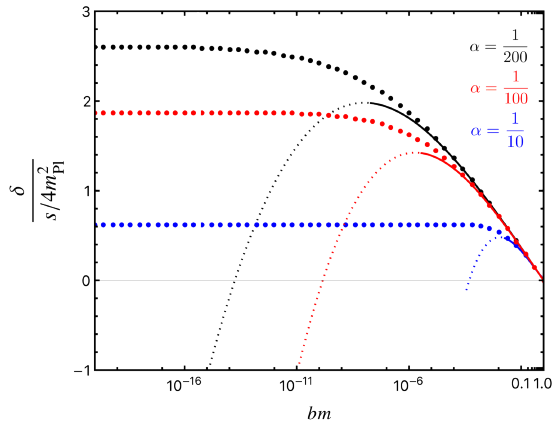
Figure 5 . Quantum corrections to the phase shift in the vector case with IR Sudakov double-logs resummation as a function of bm , choosing for simplicity b IR = 1 /m . The dots reproduce the full numerical solution for α = 1 / 10 (blue), α = 1 / 100 (red), and α = 1 / 200 (black). The solid lines for p Exp( − π/ 2 α ) < bm < 1 are the analytic approximation based on eq. (2.21). If extrapolated to the p region bm < Exp( − π/ 2 α ) , the phase shift would turn negative as displayed by the thin dotted lines. In such a regime of small bm the eq. (2.21) is however no longer valid. After resumming the IR Sudakov double-logs we find indeed a positive constant phase shift in the region bm < Exp( − and no causality